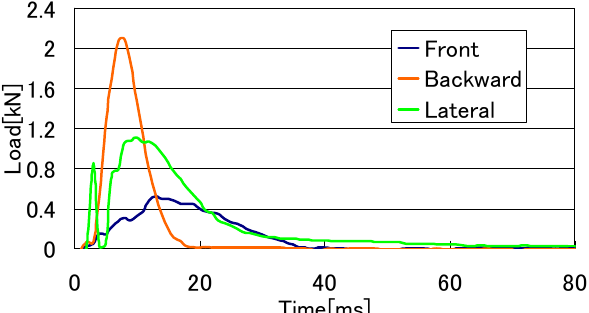
Fig. 4 Force–time responses for impacts at 15.2 [km/h] for each impact direction.